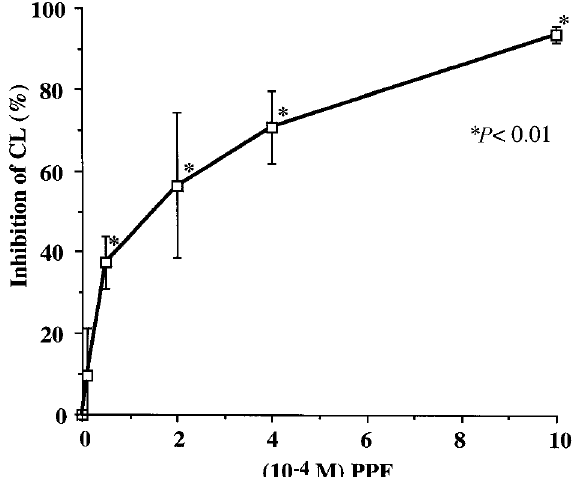
FIG. 1. Dose-dependent inhibition (±SD) of the CL of stimu- lated PMN by PPF ( n =5).